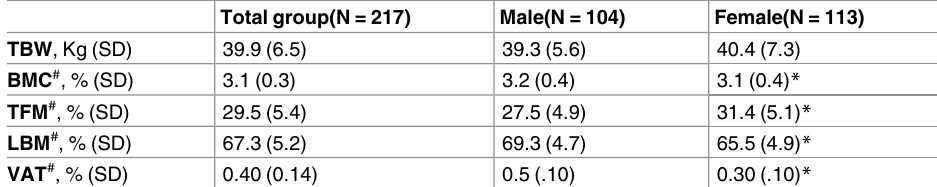
Table 2. Relative body composition.